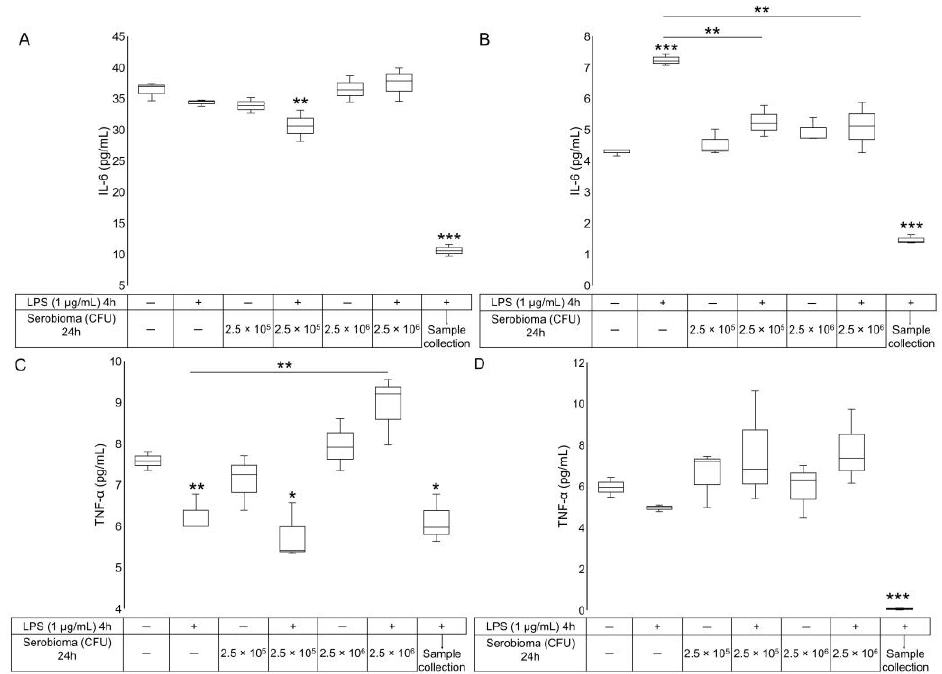
Figure 3. HMC-1.2 cytokine release after LPS/Serobioma treatment. HMC-1.2 were interfaced with ( A , C ) the Caco-2/HT-29 co-culture intestinal cells or ( B , D ) confluent HT-29 cells. Statistical analysis: one-way ANOVA followed by Dunnett’s post hoc with respect to the untreated control. Cells pre-incubated with LPS and then with Serobioma were also compared with the LPS-treated group. * p -value < 0.05, ** p -value < 0.01, *** p -value < 0.001 ( n = 3).